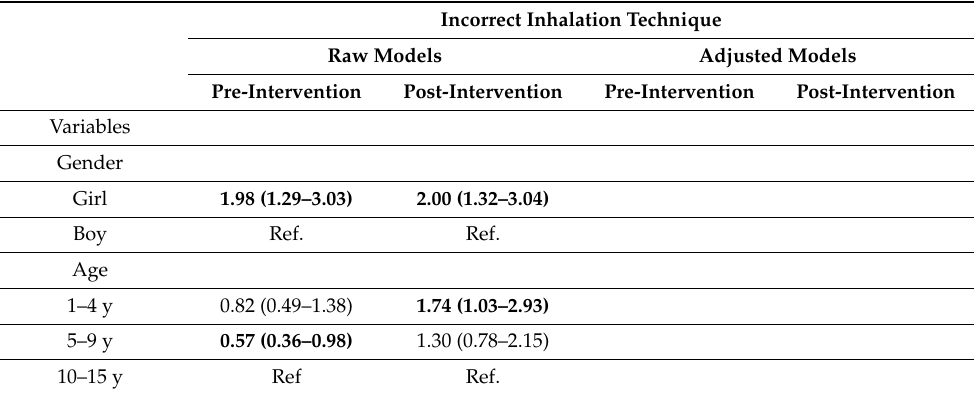
Table 3. Predictors of incorrect inhalation technique in children with respiratory diseases before and after the education intervention (reference: correct inhaltaion technique). Results from the logistic regression models, showing both odds ratio (OR) and confidence intervals (CI 95%) in a raw model and adjusted model (age and